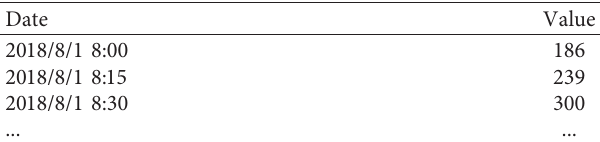
Table 2: Partial traffic data of 15 min at Qujiang Toll Station, Shaanxi Province.